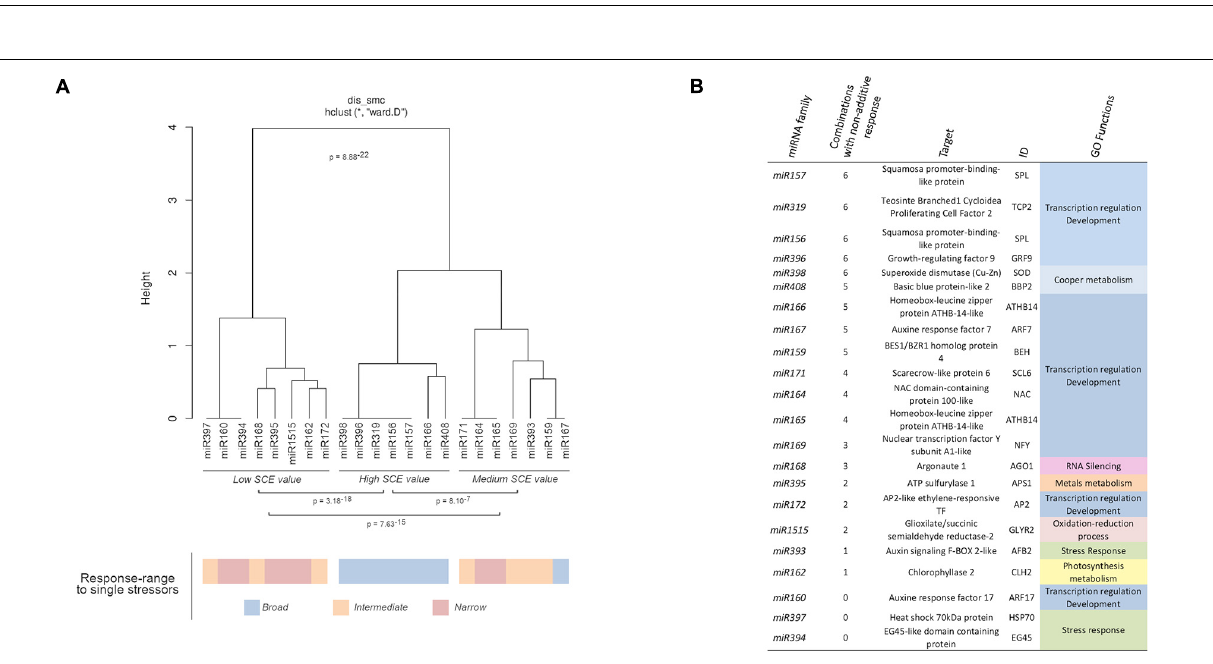
Frontiers in Plant Science |